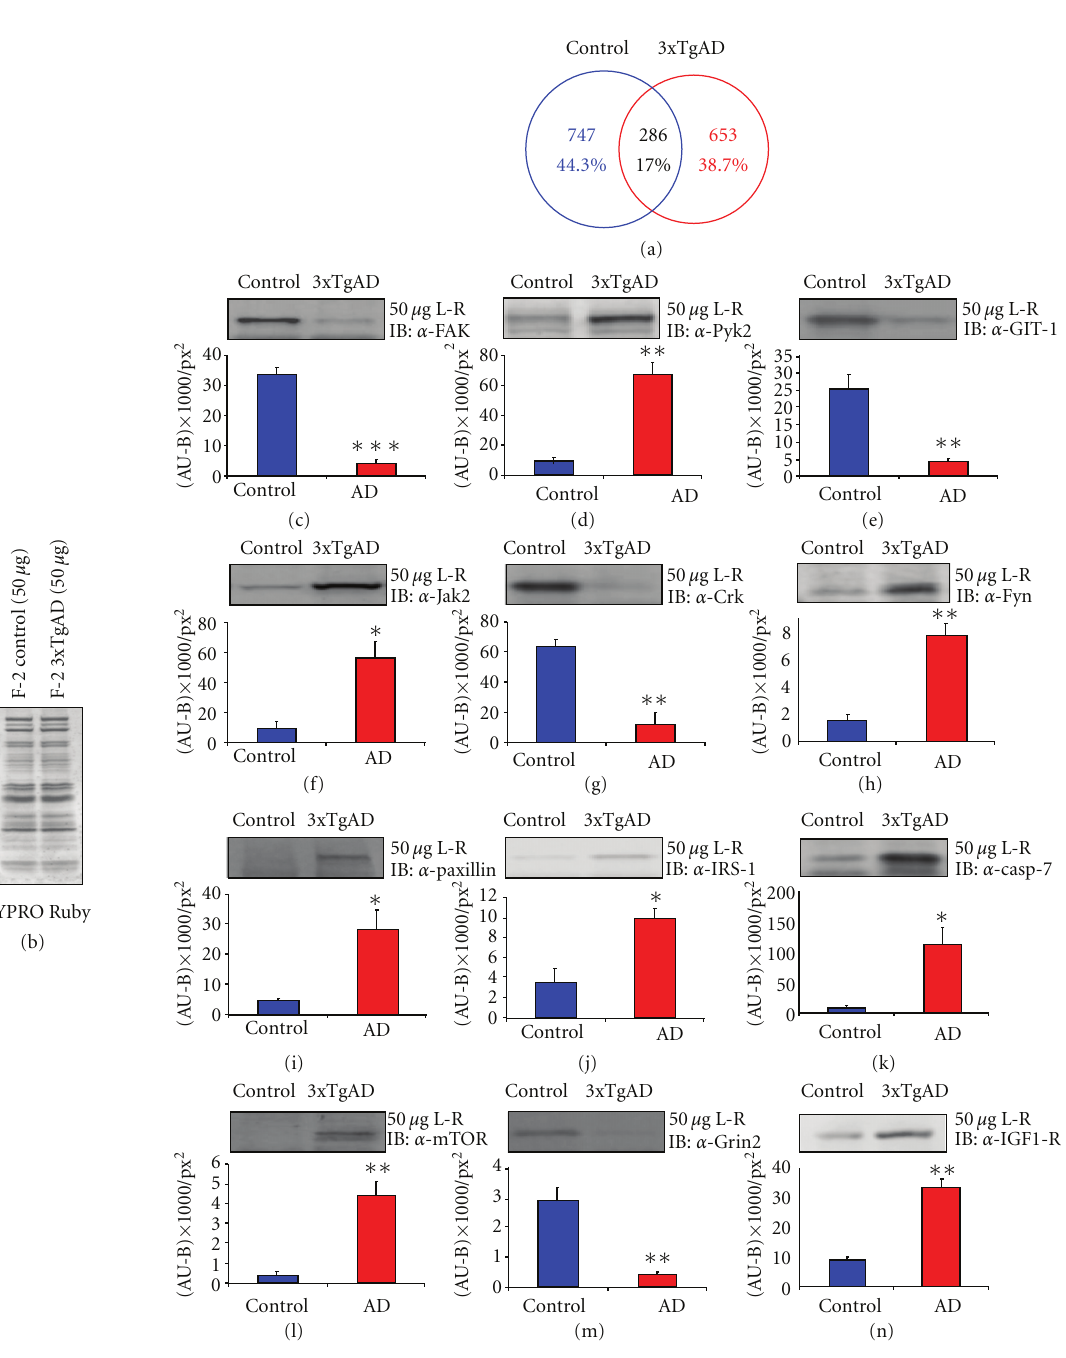
Figure 3: Di ff erential protein expression in control versus 3xTgAD lipid raft extracts. (a) Proportionately drawn Venn diagram analysis of reliably identified proteins from control lipid rafts (blue line) and 3xTgAD rafts (red line). (b) Total protein loading control for centrifugal fraction 2. A total of 50mg of fraction 2 protein was loaded and stained with SYPRO Ruby and scanned using a phosphorimager. (c)–(n). Representative western blots from multiple expression analysis experiments for di ff erential presentation of proteins in fraction 2 extracts from control (blue) or 3xTgAD mice (red). Associated with each panel (c)–(n) the associated histograms represent the mean ± s.e. mean of )) from at least three separate experiments. ∗ P < . 05; ∗∗ P < . 01; ∗∗∗ P < . 001. Protein protein expression intensity (measured in ((AU-B)/px 2 abbreviations are as follows. FAK: focal adhesion kinase; Pyk2: proline-rich tyrosine kinase 2; GIT-1: GRK interactor-1; Jak2: Janus kinase 2; Crk: v-Crk avian sarcoma virus CT10 oncogene homolog; Fyn: Fyn tyrosine kinase; IRS-1: insulin receptor substrate-1; casp 7: caspase 7; mTOR: mammalian target of rapamycin; Grin2: G protein-regulated inducer of neurite outgrowth 2; IGF-1R: insulin-like growth factor-1